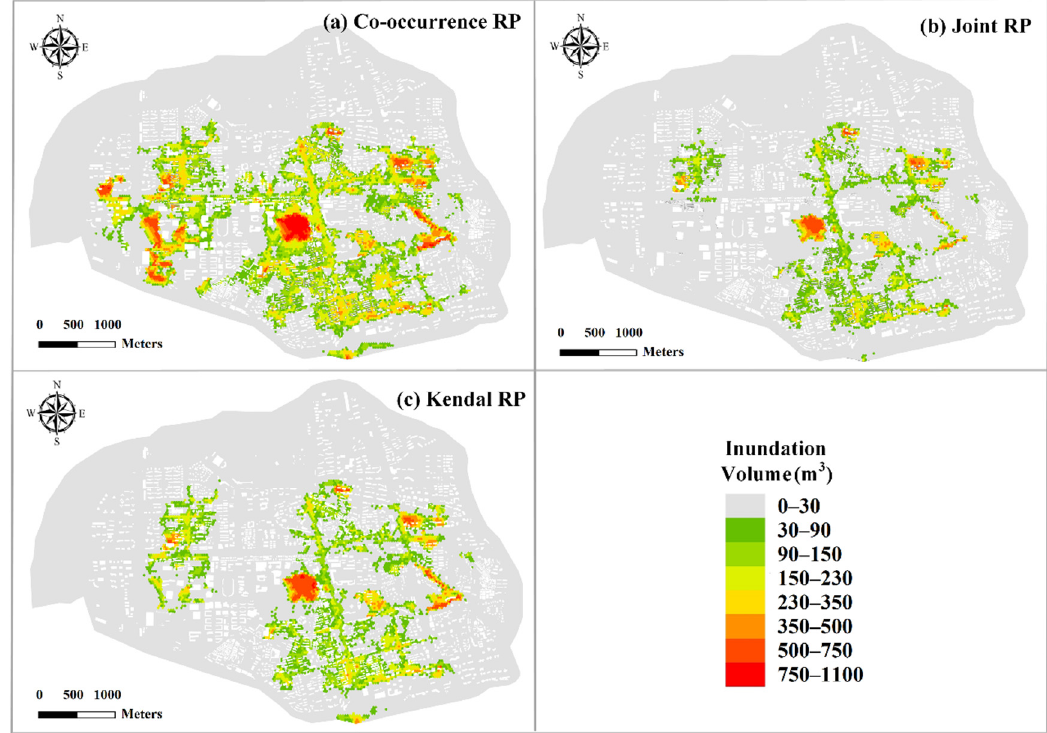
Figure 13. Comparison of inundation volumes for different types of bivariate RP.